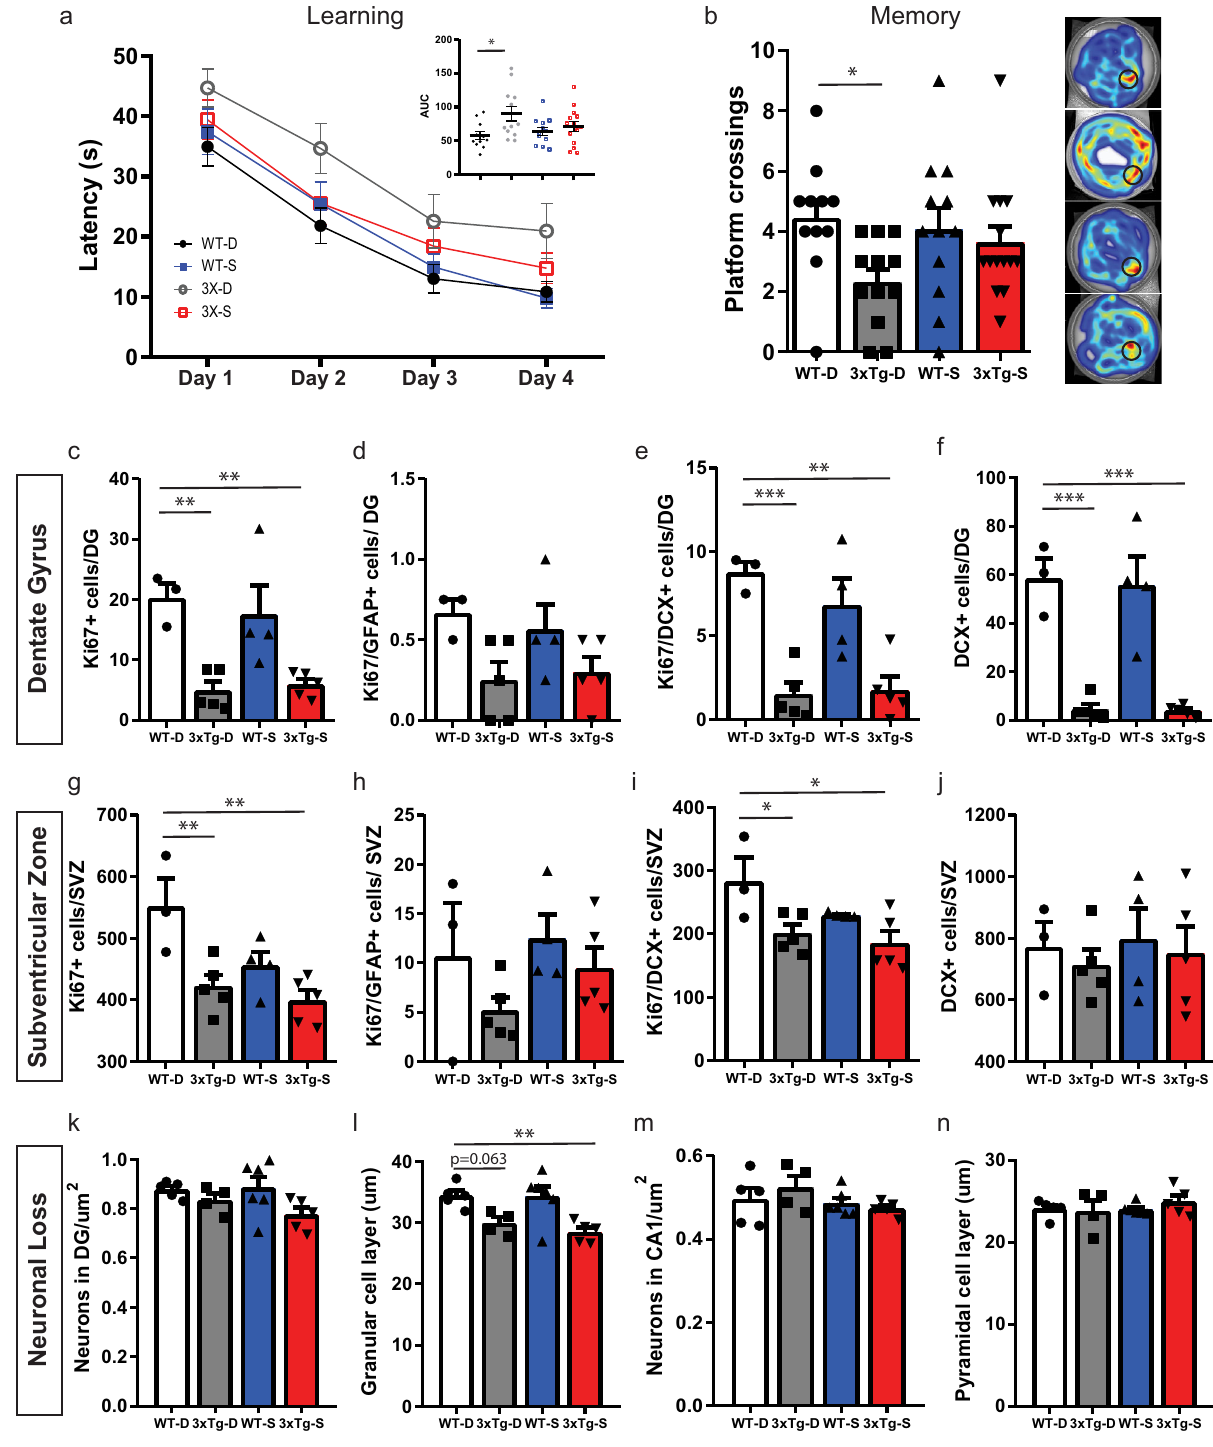
Overall, these experiments show that SCDi administration in 3xTg mice results in broad effects on hippocampal synapse- related gene expression and leads to recovery of hippocampal dendritic spines, dendritic structure and activity-related IEG expression. Single-cell analysis identi fi es MHC-I genes as main targets of SCDi in 3xTg hippocampal microglia . Microglia, the resident